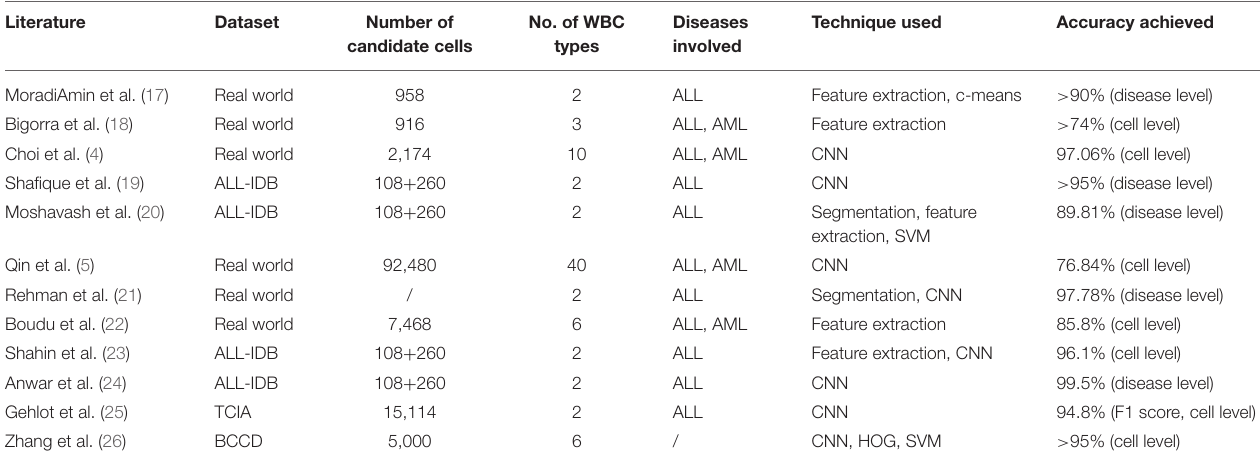
TABLE 3 | Comparison of the classification accuracy of different researches in WBC